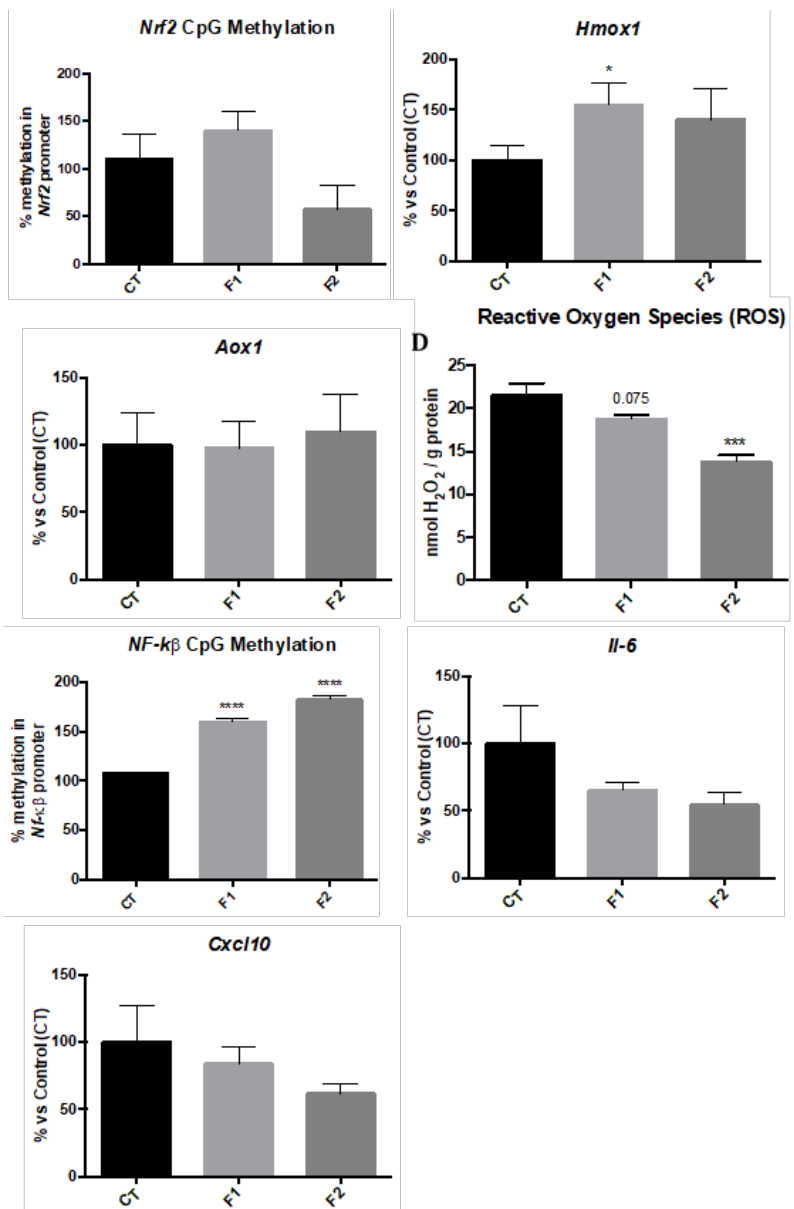
Figure 4. DNA methylation analysis of the Nrf2 ( A ) and NF-k β ( E ) gene promoter in the hippocampus of females and males at 6 months of age for all mice groups. Percentage of gene methylation was determined by real-time PCR. Mean ± values in bar graphs are adjusted to 100% for each gene of the CT mice group. Representative Oxidative stress measured as hydrogen peroxide concentration in homogenates of hippocampus tissue ( D ). Representative gene expression for Hmox1 ( B ), Aox1 ( C ), Il-6 ( F ), Cxcl10 ( G ). Gene expression levels were measured by real-time PCR from hippocampal mRNA. Mean ± SEM in bar graphs are adjusted to 100% for each gene of the CT; n = 18 (CT n = 6, F1 n = 6, F2 n = 6; for each group, females n = 3, males n = 3). Statistics: * p < 0.05; *** p < 0.001.